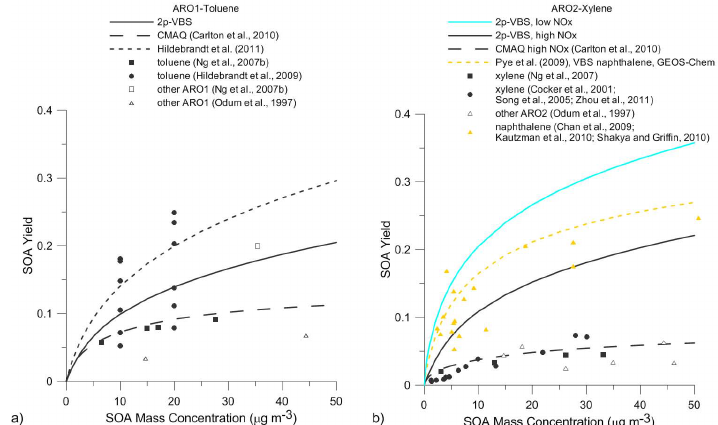
Fig. 5. Evaluation of 2p and 2p-VBS parameterizations for lumped aromatics. (a) ARO1/toluene theoretical yield curve (SOA yield vs. SOA mass concentration); (b) ARO2/xylene theoretical yield